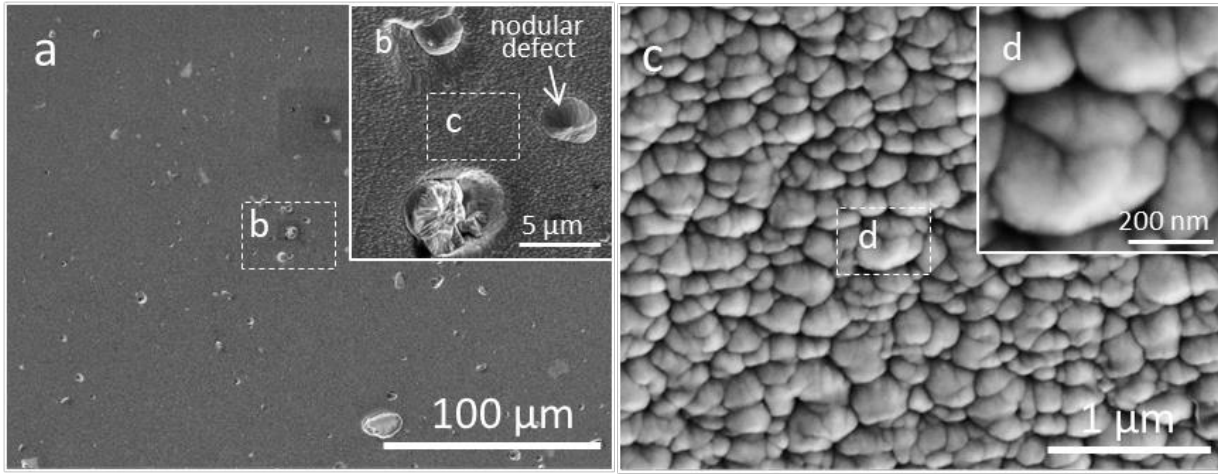
Figure 18. SEM observations of ( a ) macro-, ( c ) micro- and ( d ) nano-morphology of a magnetron sputtered nanolayer and nanocomposite coating TiAlN/TiSiN/TiAlSiN deposited on D2 tool steel substrate. Inset ( b ) shows the typical growth defects formed during deposition process.